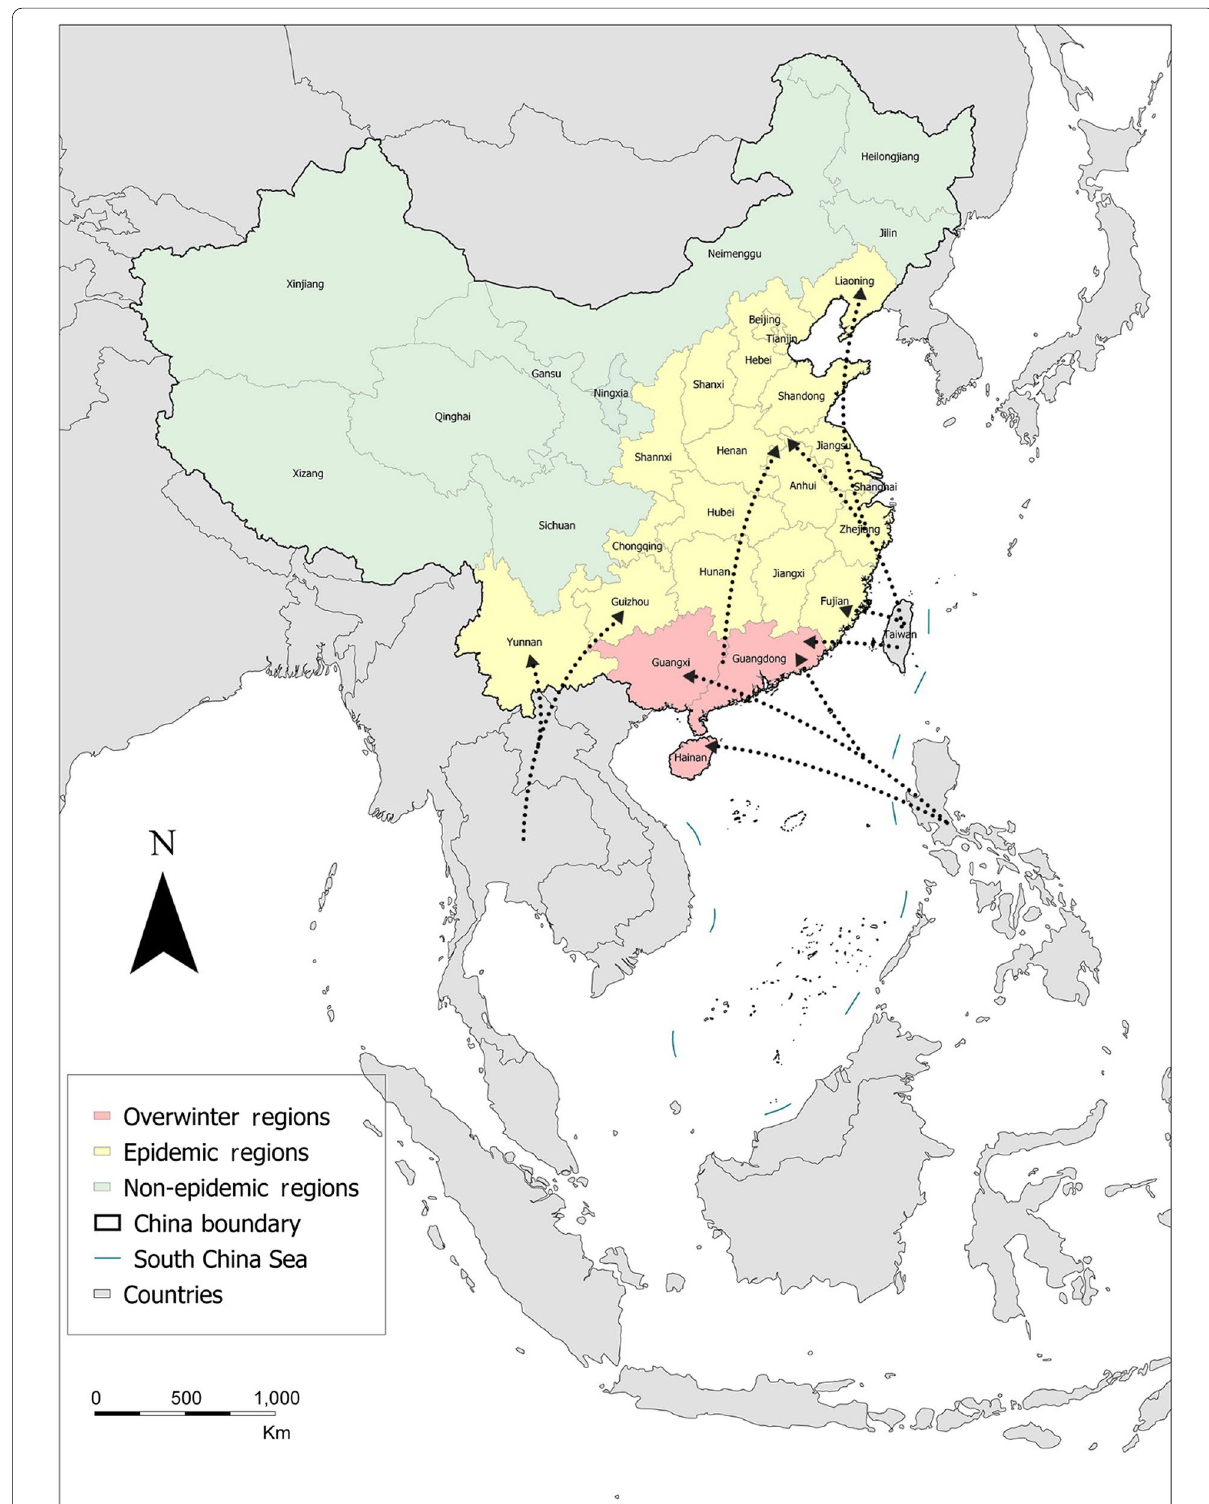
Fig. 2 The distribution of Puccinia polysora and the possible resources of primary infection of P. polysora causing southern corn rust in China. Broken black arrows indicate the possible pathway of urediniospores dispersed by the wind (Liu et al. 2018; Wang et al.